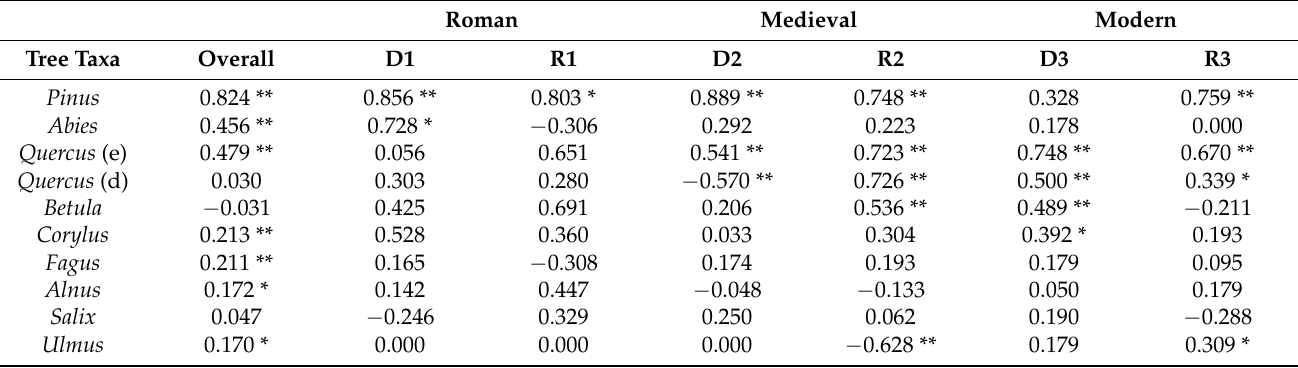
Table 3. Correlations of individual forest pollen types with total forest pollen for the total data set (overall) and for each specific deforestation and recovery phase (Figure 4). Forest types: Cf, conifer forest; Msf, Mediterranean sclerophyll forest; Sdf, submontane deciduous forest; Rf, riverine forest. Correlation significance: * p < 0.05; ** p < 0.01. Roman Medieval